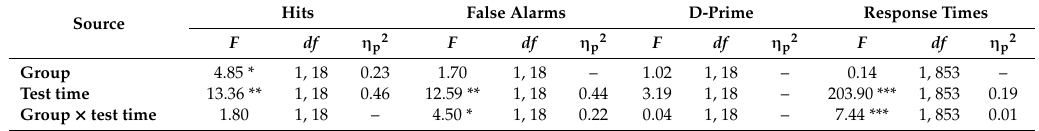
Table 4. Summary for ANOVAs performed on hits, false alarms, d-primes, and response times. Hits False Alarms D-Prime Response Times Source